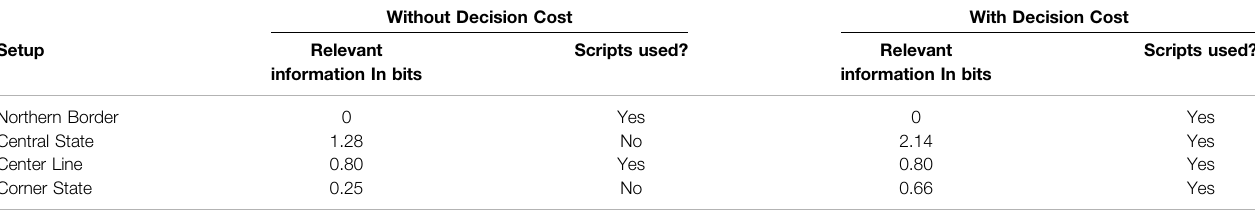
TABLE 1 | Relevant information and occurrences of scripts for the different goal setups.